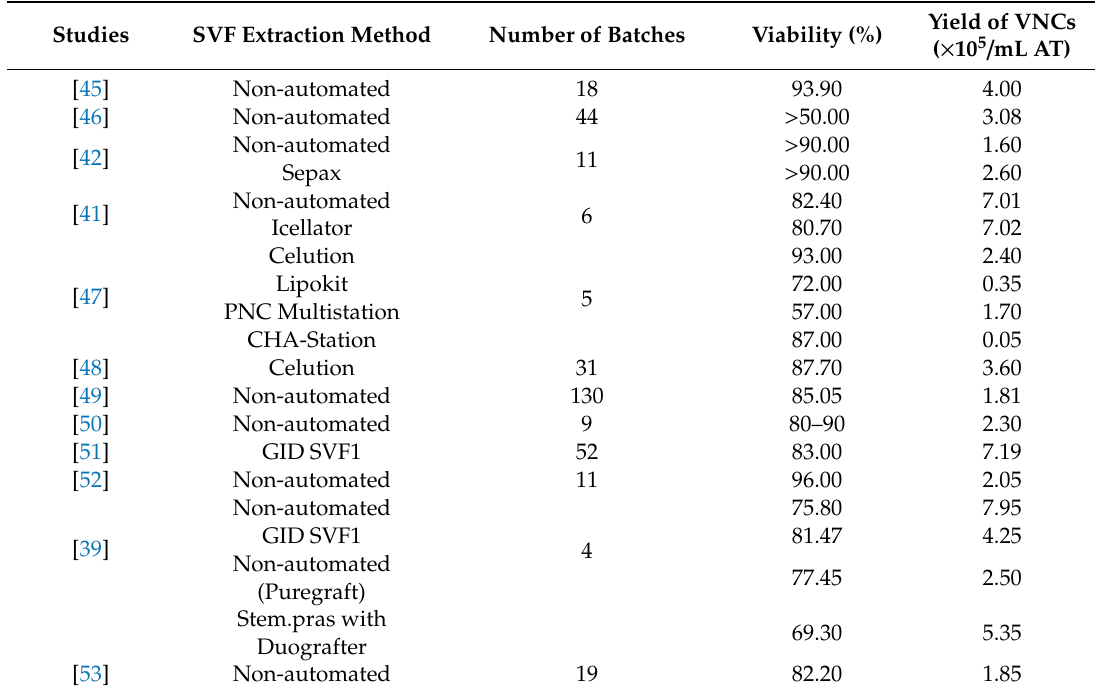
Table 3. Yield recovery and viability from 12 SVF extraction studies. Studies that reported both viability and yield recovery after enzymatic digestion were selected. The reference of the study is provided in the first column. The method of SVF extraction is reported in the second column; if an automated or medical device was used, it is specified. The third column shows the number of batches on which the results were evaluated. The two last columns indicate the percentage of viability and yield recovery per mL of AT. It is important to note that the determination of viability and recovery yield were not conducted by the same method in each study. Comparison with the LG protocol was conducting using the inter-donor comparison value.